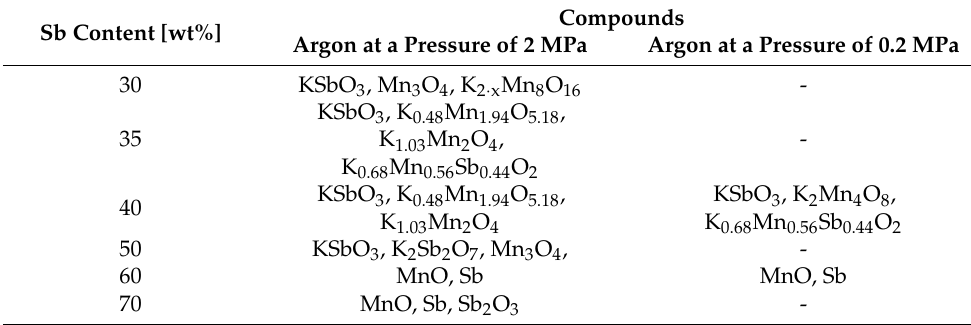
Table 3. Solid products of combustion identified by XRD